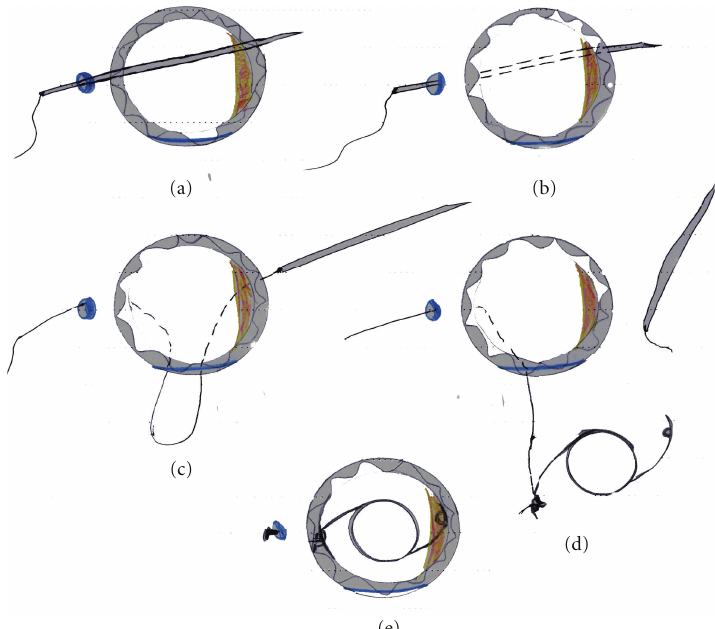
Figure 1: Steps of one-haptic scleral fixation posterior chamber IOL. (a) The needle is inserted into the anterior chamber. (b) The needle is directed toward the opposite limbus. (c) The thread is pulled externally through corneal incision. (d) The suture ends are tied to the haptic. (e) The suture-fixated IOL is placed after the external ends are